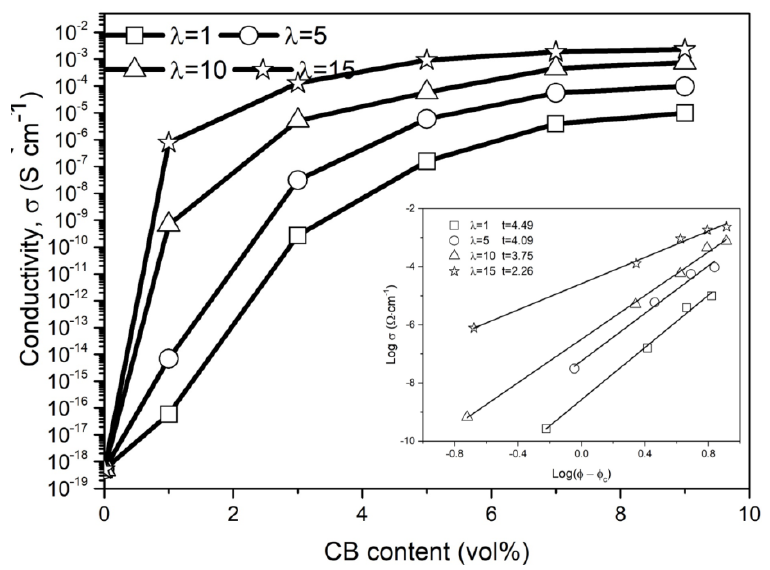
Figure 5. Electrical conductivity of the CB/PA6/PP composites with CB content; the inset is the log( φ − φ c ) vs. log σ plot.